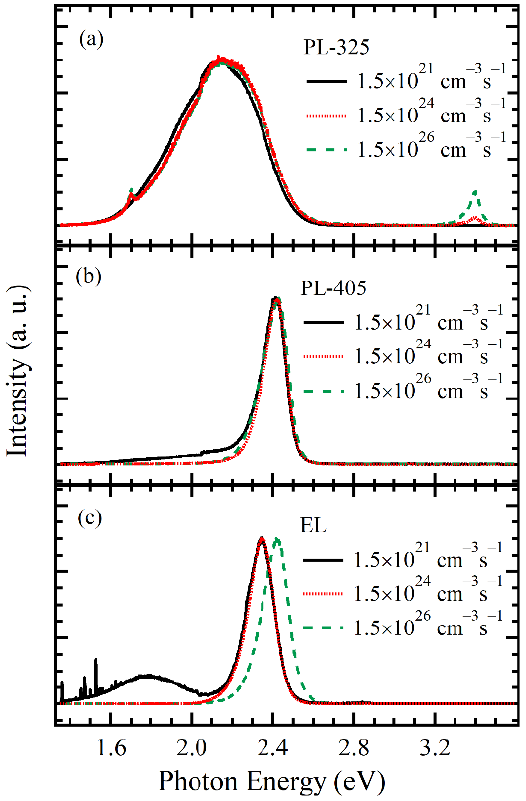
Figure 2. Normalized spectra of the InGaN/GaN MQWs in 300 K measured under excitation by 325-laser ( a ), 405-laser ( b ), and current ( c ), respectively.